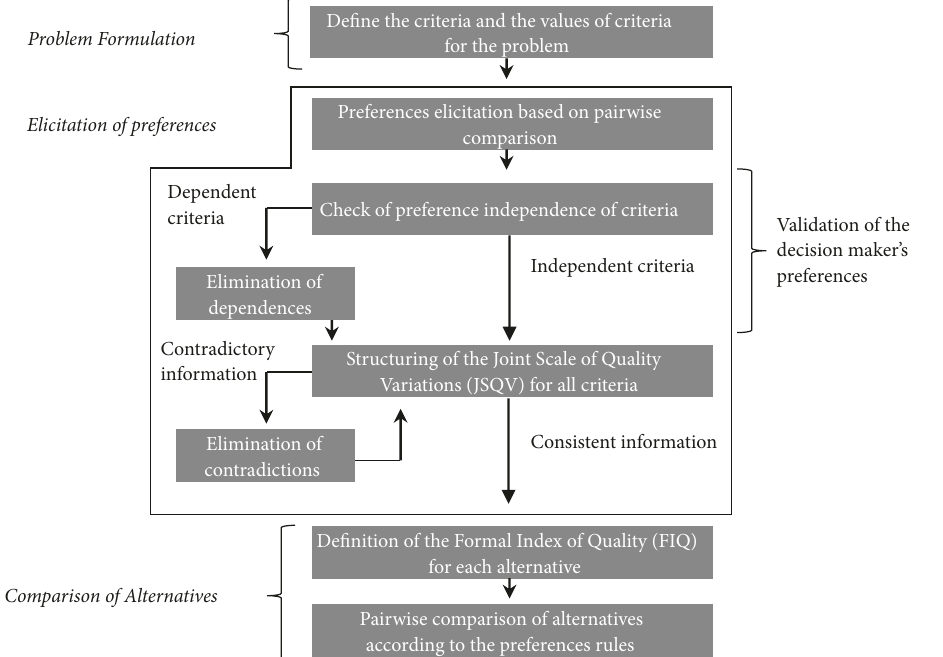
Figure 5: Procedure to apply ZAPROS III- i method